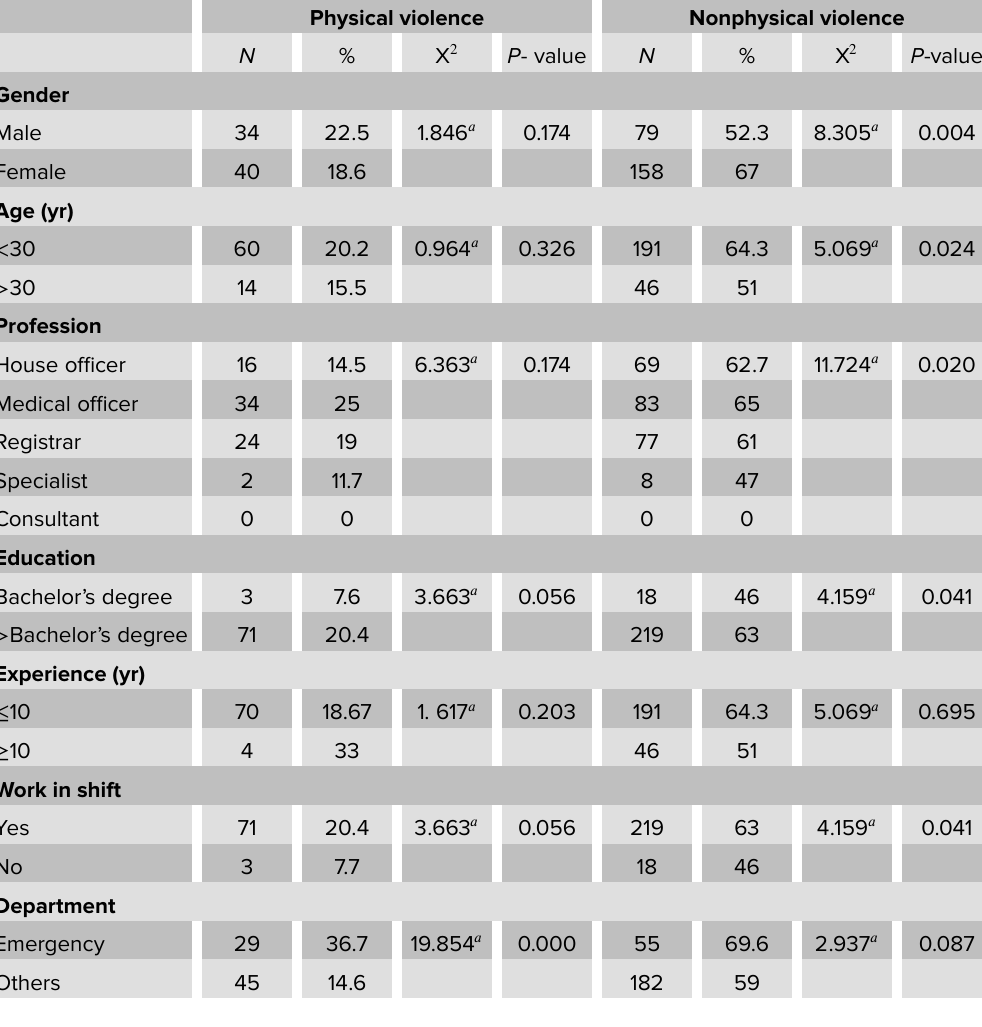
TABLE 1: Association between exposure to violence and respondents’